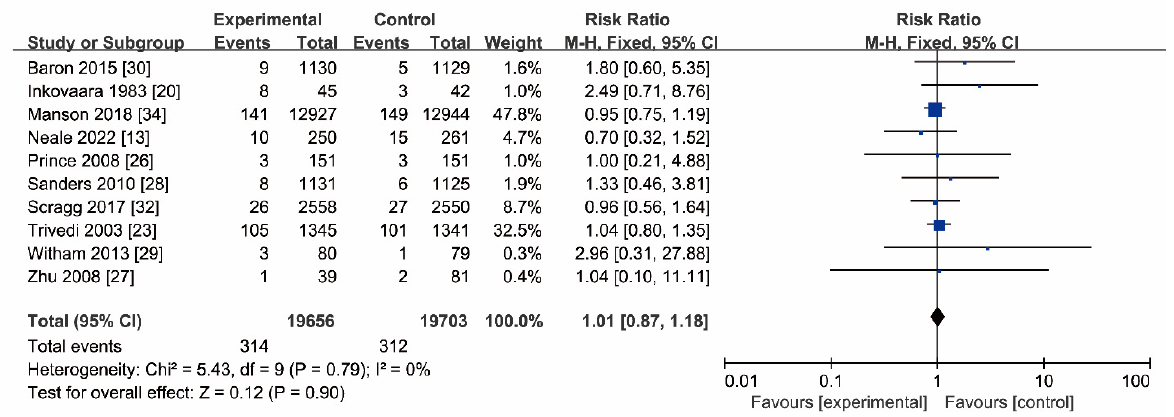
Table 3. Subgroup analysis of the effect of vitamin D supplementation for CVD.